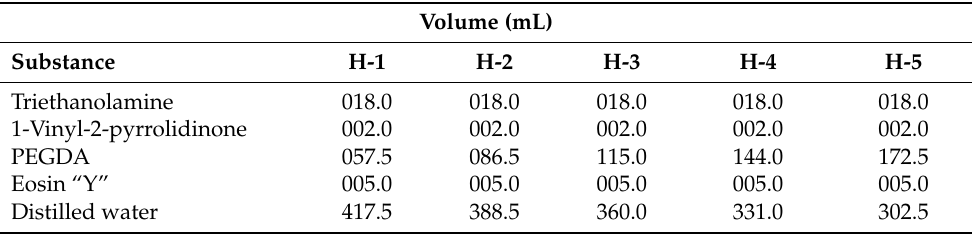
Table 1. Volume of the components used for each formulation. The solutions were filled to a volume of 500